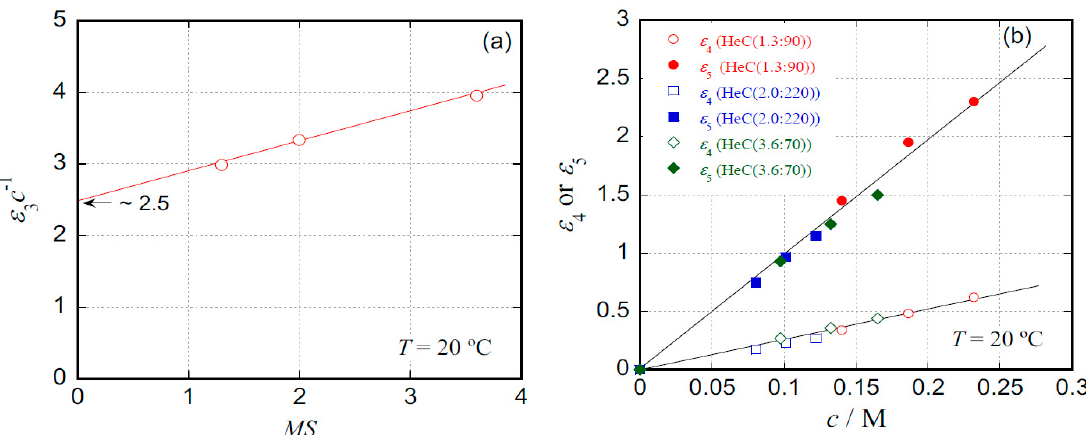
Figure 3. ( a ) Molar substitution number, MS , dependence of normalized dielectric relaxation strength, ε 3 c − 1 , for mode j = 3. ( b ) Concentration dependence of dielectric relaxation strength for mode j = 4 and 5 observed in aqueous solutions of HeC(1.3:90), HeC(2.0:220), and HeC(3.6:70).